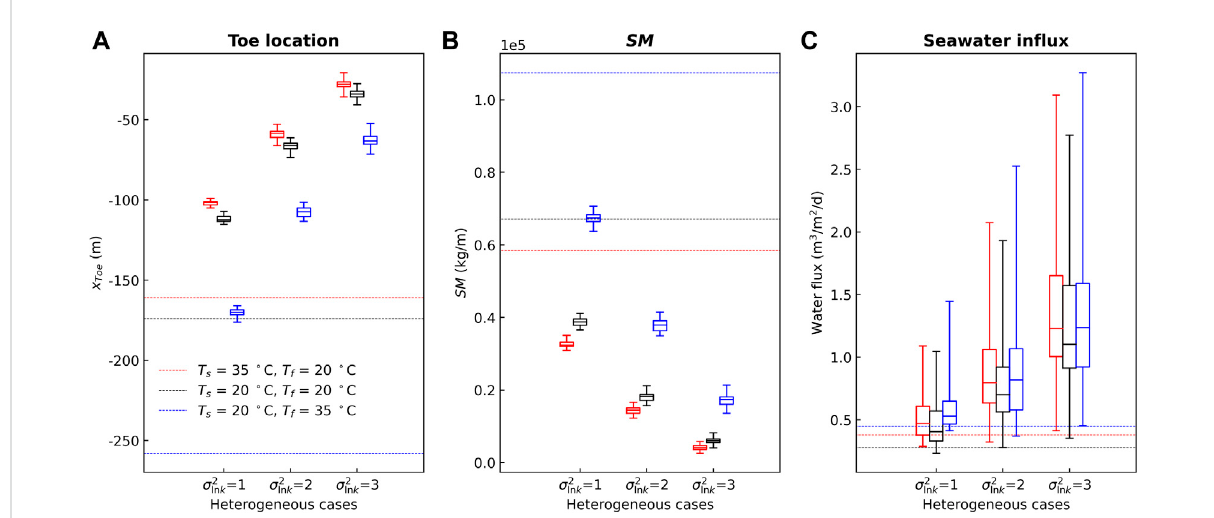
FIGURE 8 Box plots ( n = 50) for heterogeneous aquifers under different permeability variances ( σ 2 ln k = 1, 2, and 3, respectively) and FW-SW temperature contrasts. The left-hand, middle and right-hand panels are the results for (A) the toe location, (B) the total amount of salt mass stored in the aquifer ( SM ), and (C) the total seawater in fl ux across the aquifer-sea interface, respectively. λ x is fi xed at 0.5 m. The dashed lines are the results for homogeneous aquifers. T s and T f are seawater and freshwater temperatures, respectively.